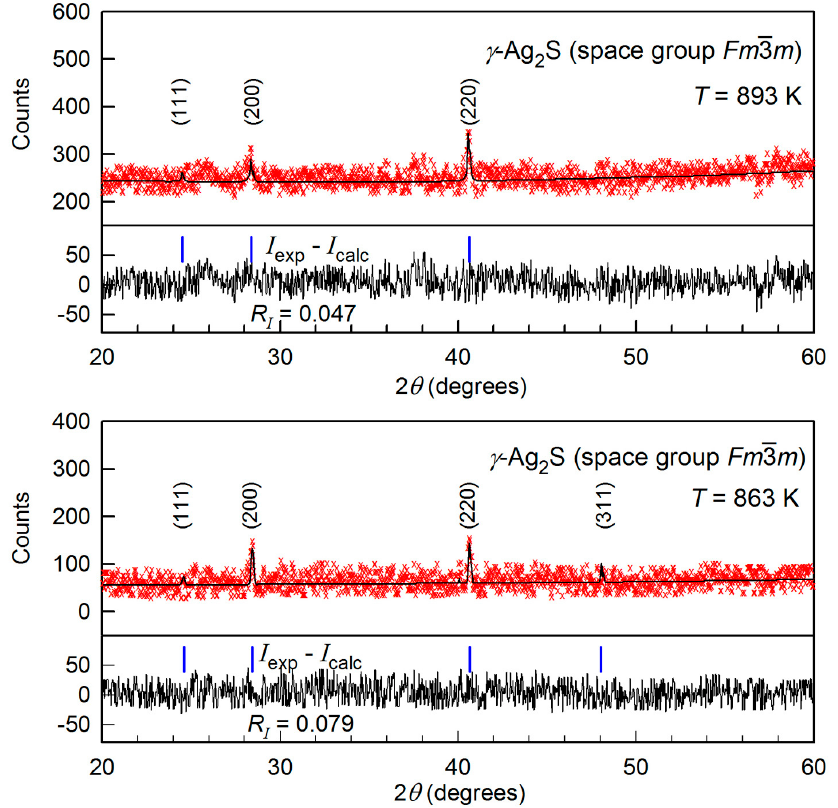
Figure 5. Experimental ( × ), calculated (—), and difference ( I exp — I calc ) XRD patterns of Ag 2 S pressed pill at temperatures of 863 and 893 K. Silver sulfide has a face-centered cubic (fcc) (space group Fm 3 m ) γ -Ag 2 S structure at 863 and 893 K.